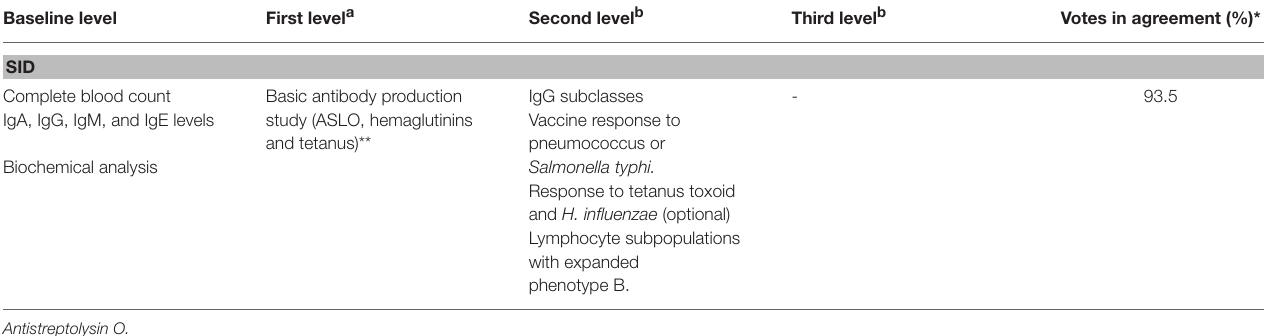
TABLE 4 | Haematological tests to be performed in patients with suspected SID.